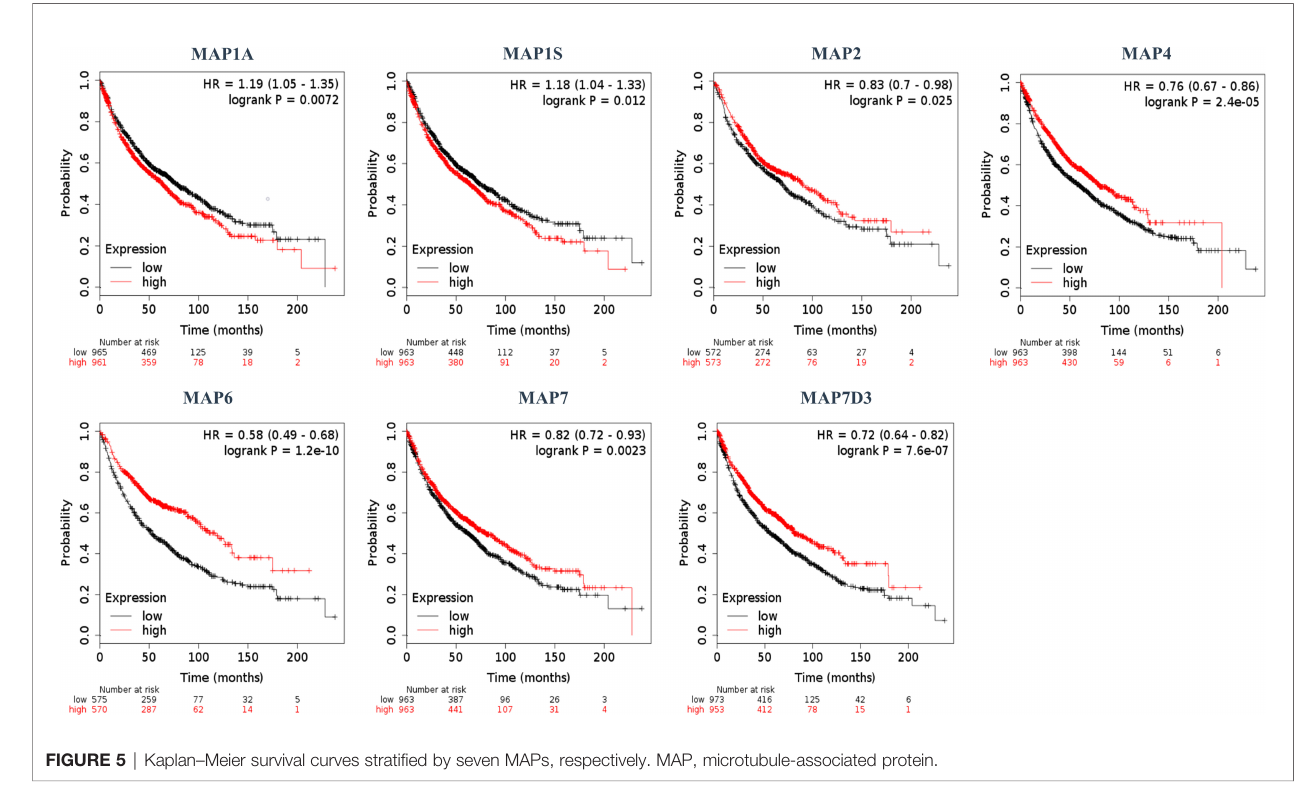
FIGURE 5 | Kaplan – Meier survival curves strati fi ed by seven MAPs, respectively. MAP, microtubule-associated protein.